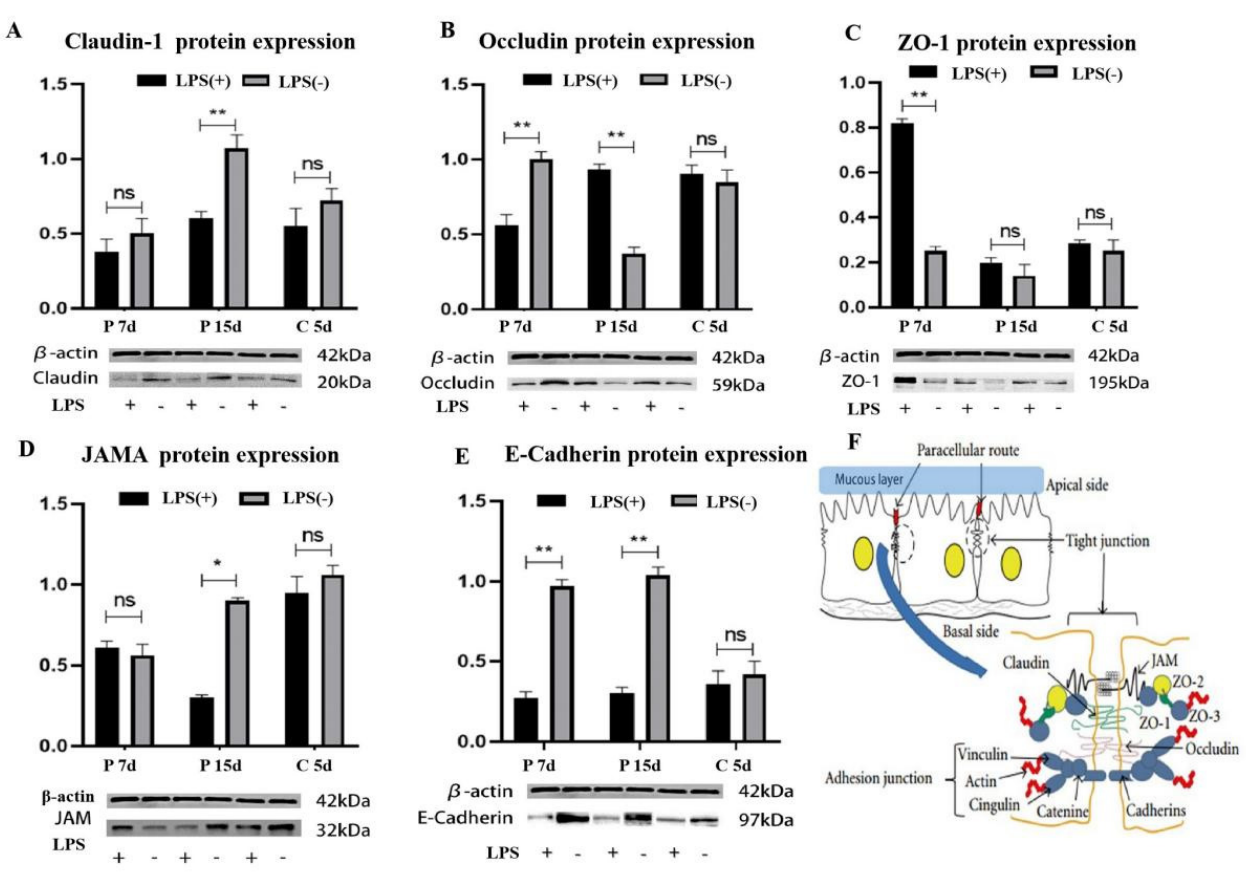
Figure 4. Effect of LPS on tight junction protein of endometrial epithelial cells at day 7 and day 15 of pregnancy and day 5 after childbirth. Claudin-1 protein expression in the uteri of female mice after LPS treatment ( A ). Occludin protein expression in the uteri of female mice after LPS treatment ( B ). ZO-1 protein expression in the uteri of female mice after LPS treatment ( C ). JAMA protein expression in the uteri of female mice after LPS treatment ( D ); E-cadherin protein expression in the uteri of female mice after LPS treatment ( E ); and the structure diagram of endometrial epithelial cells ( F ). * Statistical difference between LPS (+) and LPS (-) groups in the same period ( p < 0.05); ** statistical difference between LPS (+) and LPS (-) groups in the same period ( p <